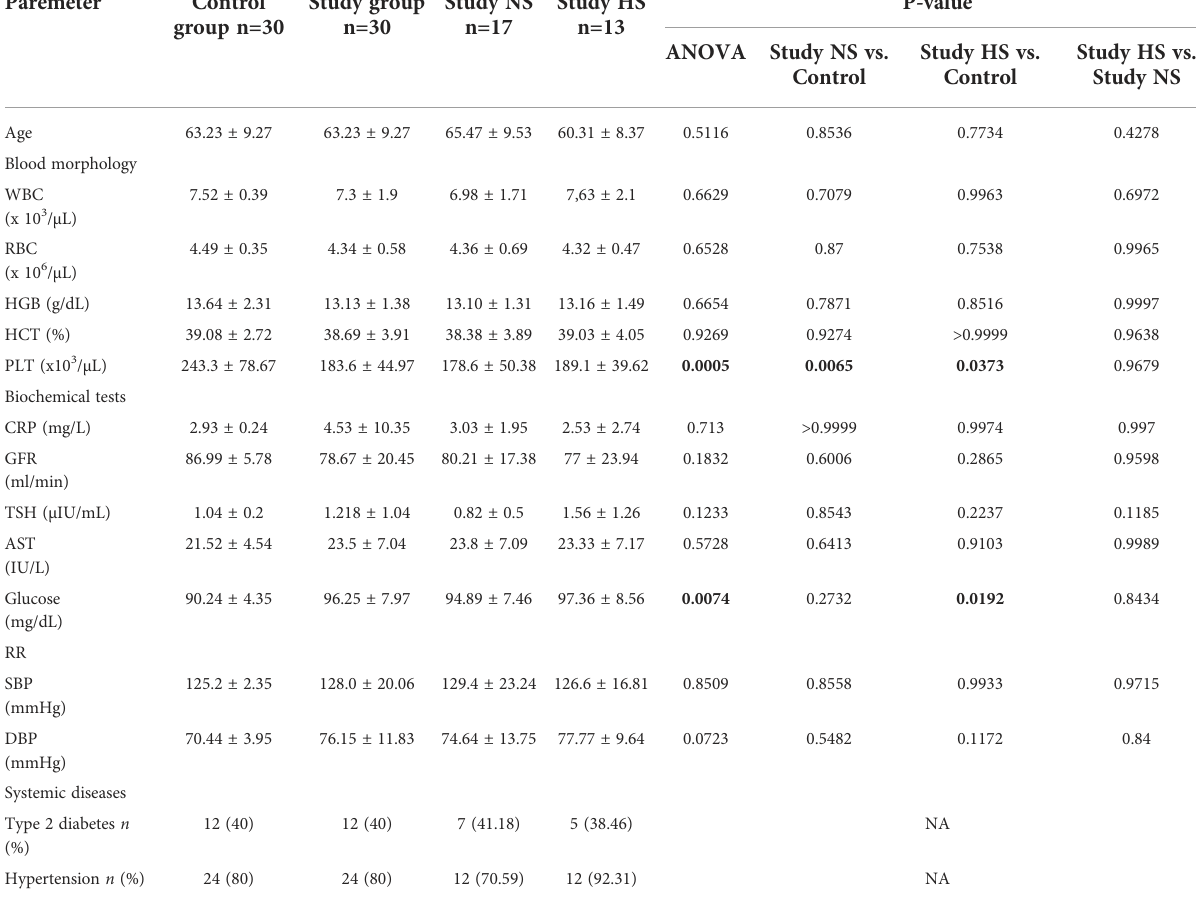
TABLE 2 Clinical characteristics of HF patients and the control group.